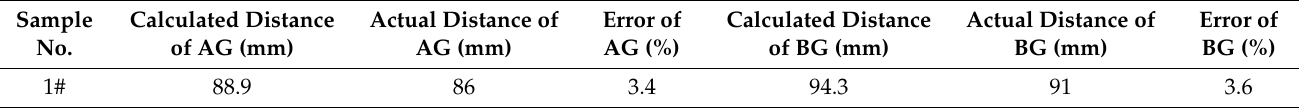
Figure 14. ( a ) Calculation mark of center of gravity and center of form; ( b ) Measuring the center-of-gravity with rope Scheme 9. Center-of-gravity calculation and measurement. Table 9. Center-of-gravity calculation and